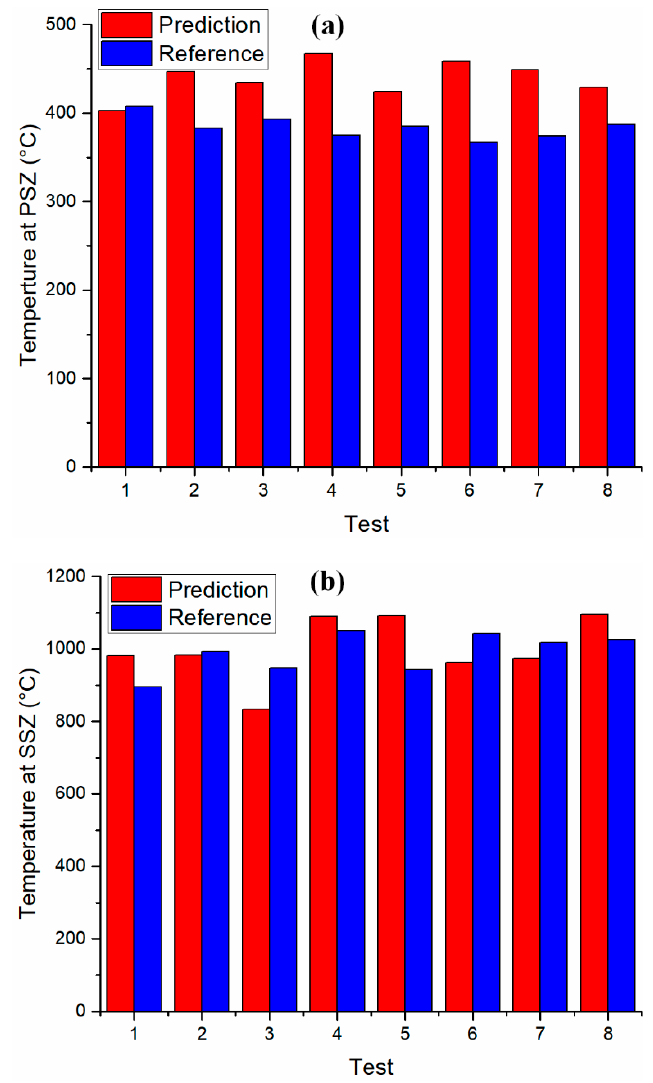
Figure 3. Temperature validation against documented values in the orthogonal cutting of AISI 1045 steel [21,28]. ( a ) Validation of temperature prediction at the primary shear zone. ( b ) Validation of temperature prediction at the secondary shear zone.